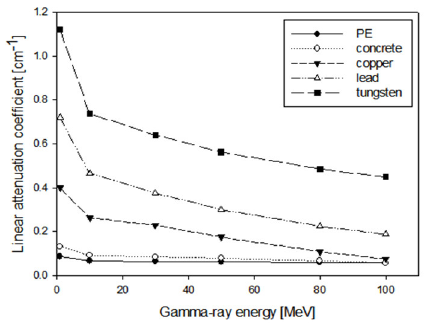
Figure 5. Linear attenuation coefficient of materials.